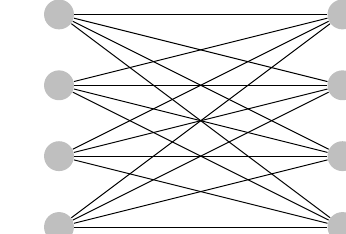
subgroup. The p gauging marked, p